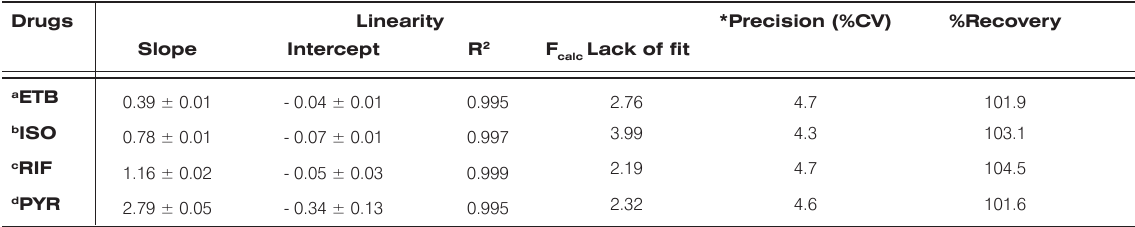
Figure 5. Plots forETB, ISO, RIF and PYR PLS2 modeling ( ● ) standard mixture solutions- calibration; ( ▼ ) 4-DFC tablets Table 3. Quantification values of 4-FDC by CZE.